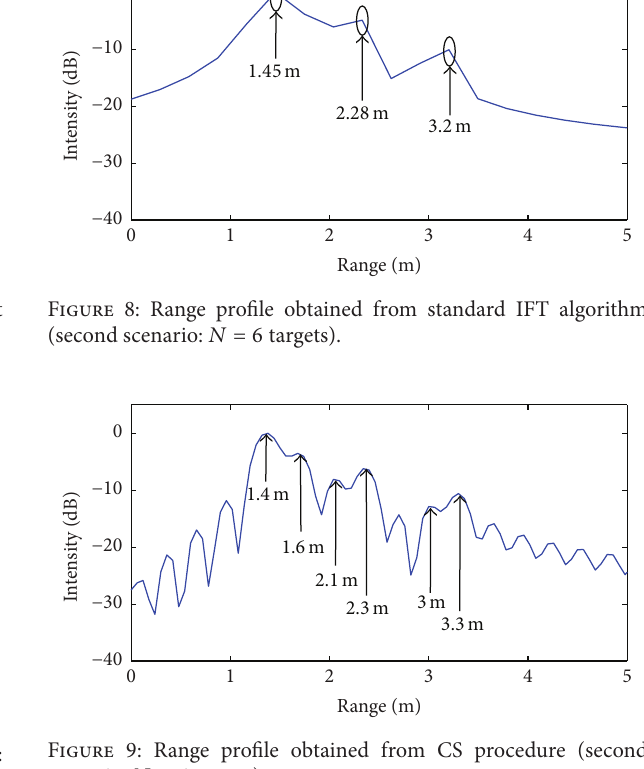
Figure 7: Range profile obtained from CS procedure (first scenario: 𝑁 = 4 targets).